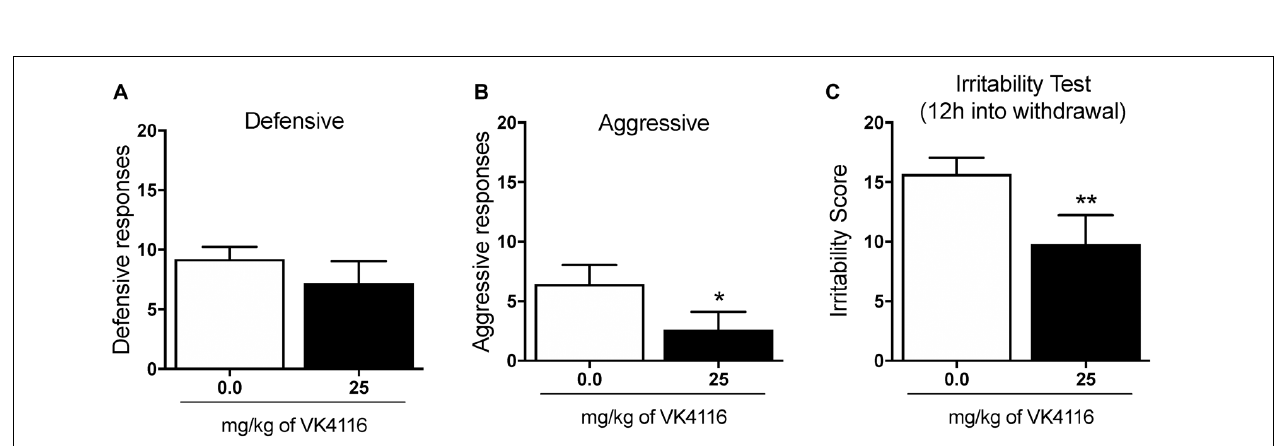
FIGURE 5 | Effect of VK4116 on oxycodone withdrawal-induced irritability-like behavior. (A) Number of defensive responses. (B) Number of aggressive responses. (C) Total irritability score (defensive + aggressive). ∗ p < 0.05, ∗∗ p < 0.01, vs. 0 mg/kg.